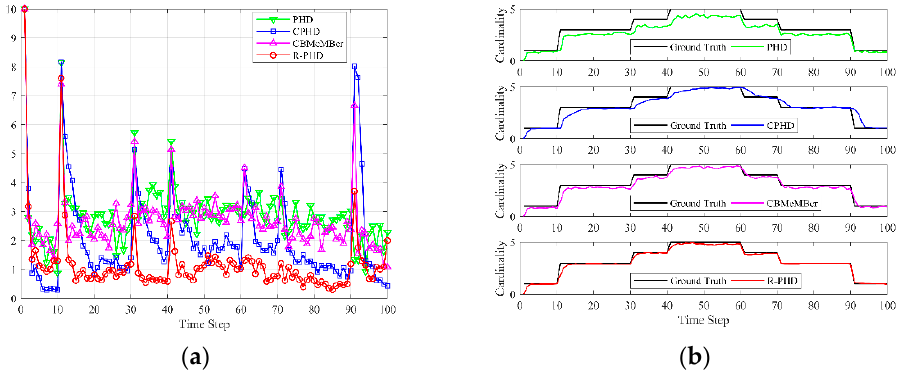
Figure 3. OSPA and cardinality performances of di ff erent methods versus time ( p D = 0.85, λ = 10): ( a ) mean OSPA; ( b ) mean